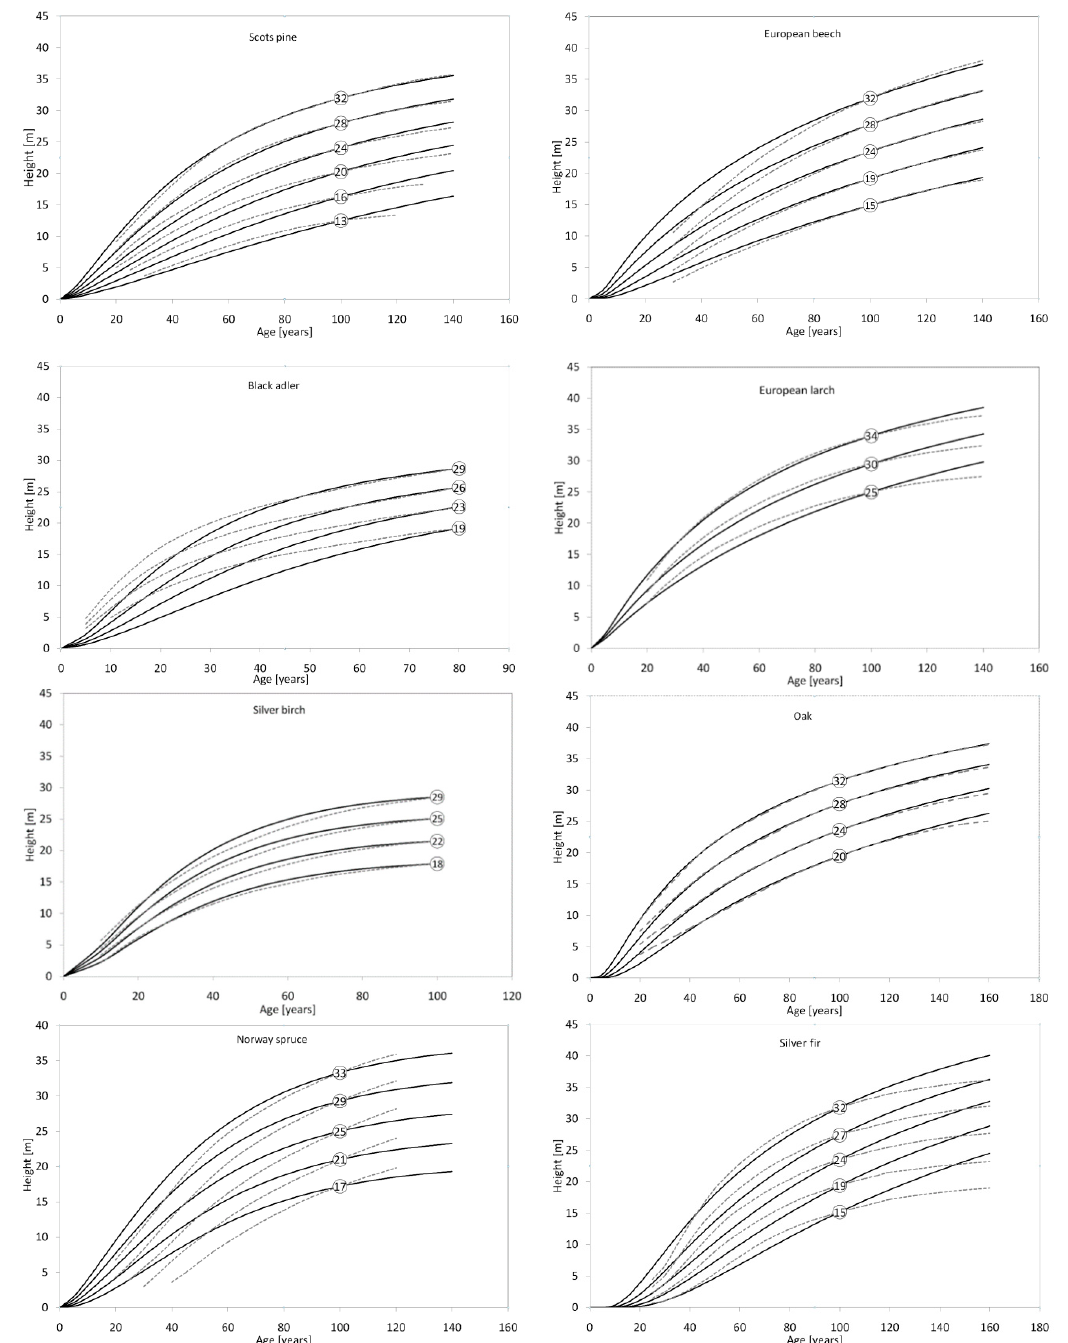
Figure 4. Height growth curves from the selected site index models (solid lines) against those obtained from yield tables (dotted lines). The numbers in circles show the corresponding values of the site index.